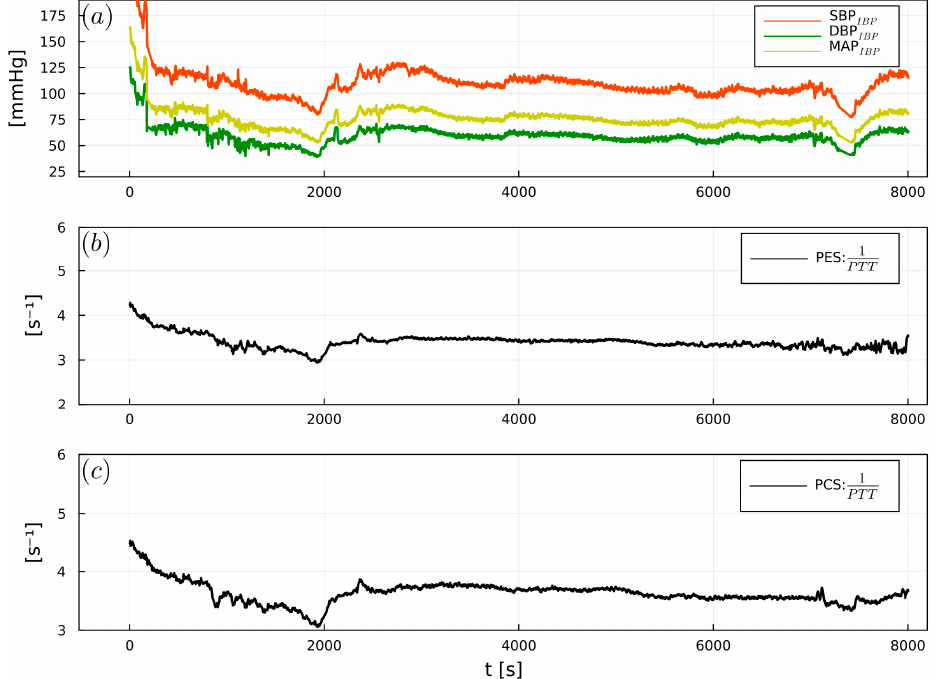
Figure 8. Example of ( a ) intraoperative SBP IBP (red), DBP IBP (green), and MAP IBP (yellow), ( b ) 1/PTT PES , ( c ) 1/PTT PCS , from an abdominal surgery patient.